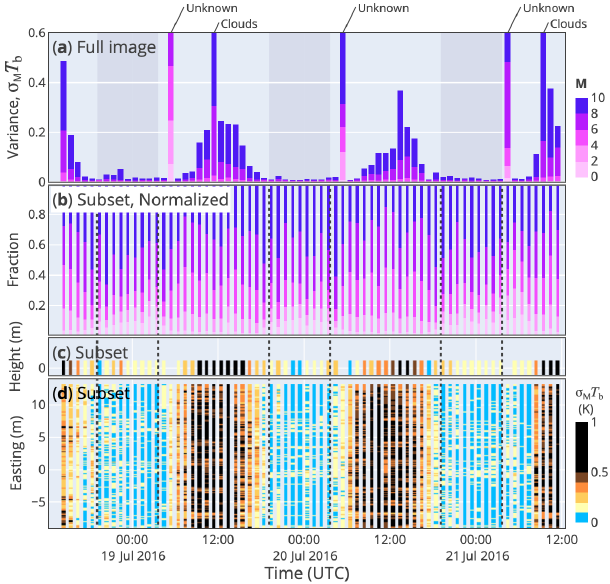
Figure 7. Shown against time for the MRD of T b are (a) the sum of variance for the full thermal image, (b) the relative contribution of each decomposition level, (c) the total sum of variance, σ M T b , and (d) the total sum of variance per grid cell in a subset image area. The subset includes grid cells depicting vegetation within 1m of a fibre-optic profile, for which the cell location is expressed relative to the centre of the domain. See text for